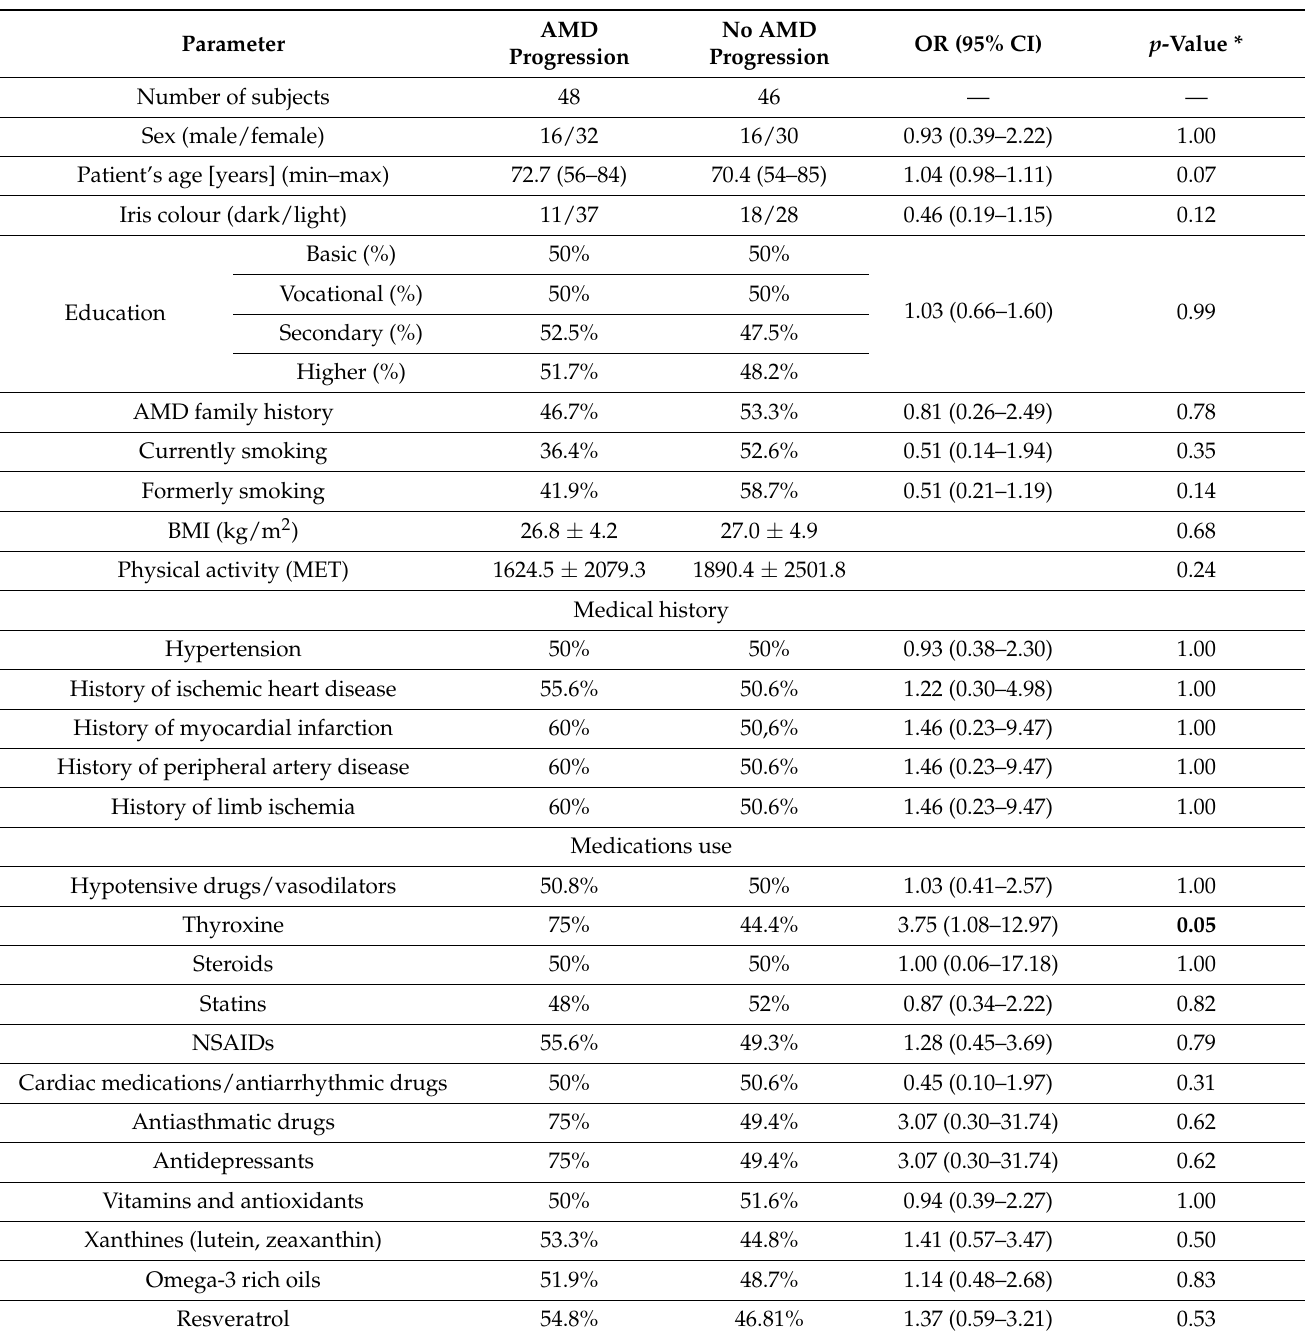
Table 1. Characteristics of the study subjects. Disease progression with regard to demographic data and medical history. The data are presented as the mean ± SD or